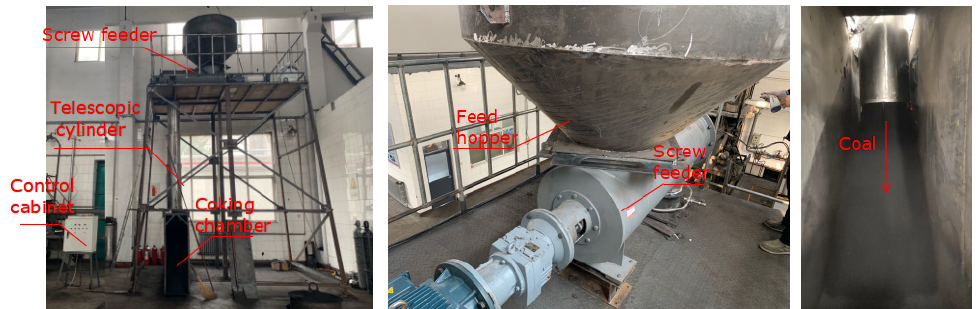
Figure 2. Coal charging